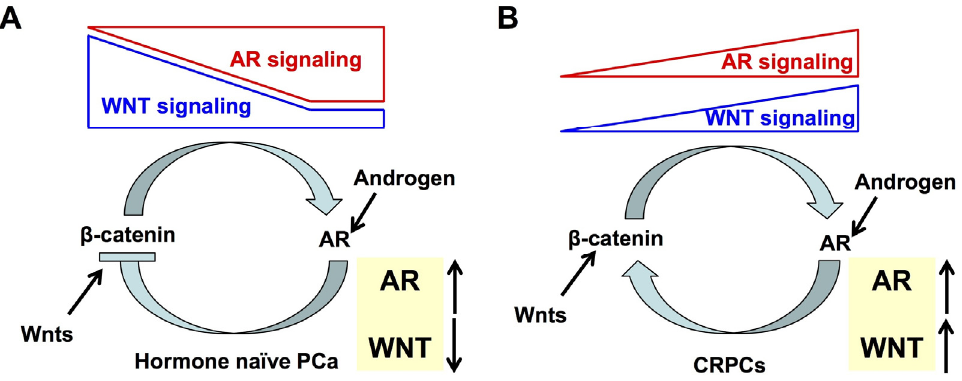
Figure 4. A simplified model of interaction between WNT and AR signaling during PCa development and progression. ( A ): In hormone naïve PCa cells, AR signaling inhibits the transcription of WNT/ β -catenin target genes, while WNT/ β -catenin signaling promotes transcription of AR target genes. Relative levels (i.e., anti-correlation but may reach to an equilibrium) of WNT (blue) and AR (red) signaling are indicated. ( B ): In CRPCs, AR and WNT/ β -catenin signaling pathways stimulate each other to activate specific target genes for promoting androgen-independent growth and progression of PCa cells. Relative levels (i.e., positive correlation) of WNT (blue) and AR (red) signaling are indicated.